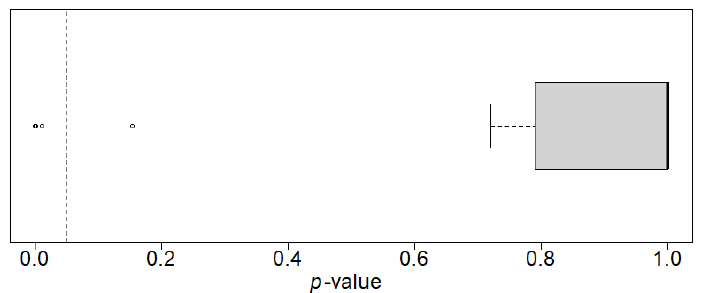
Figure 13. p -values of the Holm-corrected Kolmogorov–Smirnov tests of the distributions of estimated stem orientation angles against the reference data on n = 36 sample blowdown areas. The dashed line indicates the p = 0.05 threshold.